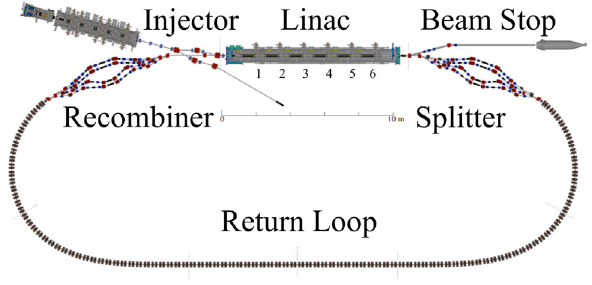
FIG. 1. Layout of the CBETA ERL [3]. A 6 MeV beam is generated in the injector, accelerates through a linac with six 7-cell cavities, circulates clockwise through the return loop, and recirculates to cover a total of 4 accelerating and 4 decelerating linac passes. The particle path concludes at the beam stop (top right). Splitter and recombiner regions at either end of the linac independently control the flight times of beams with the target energies of the 4